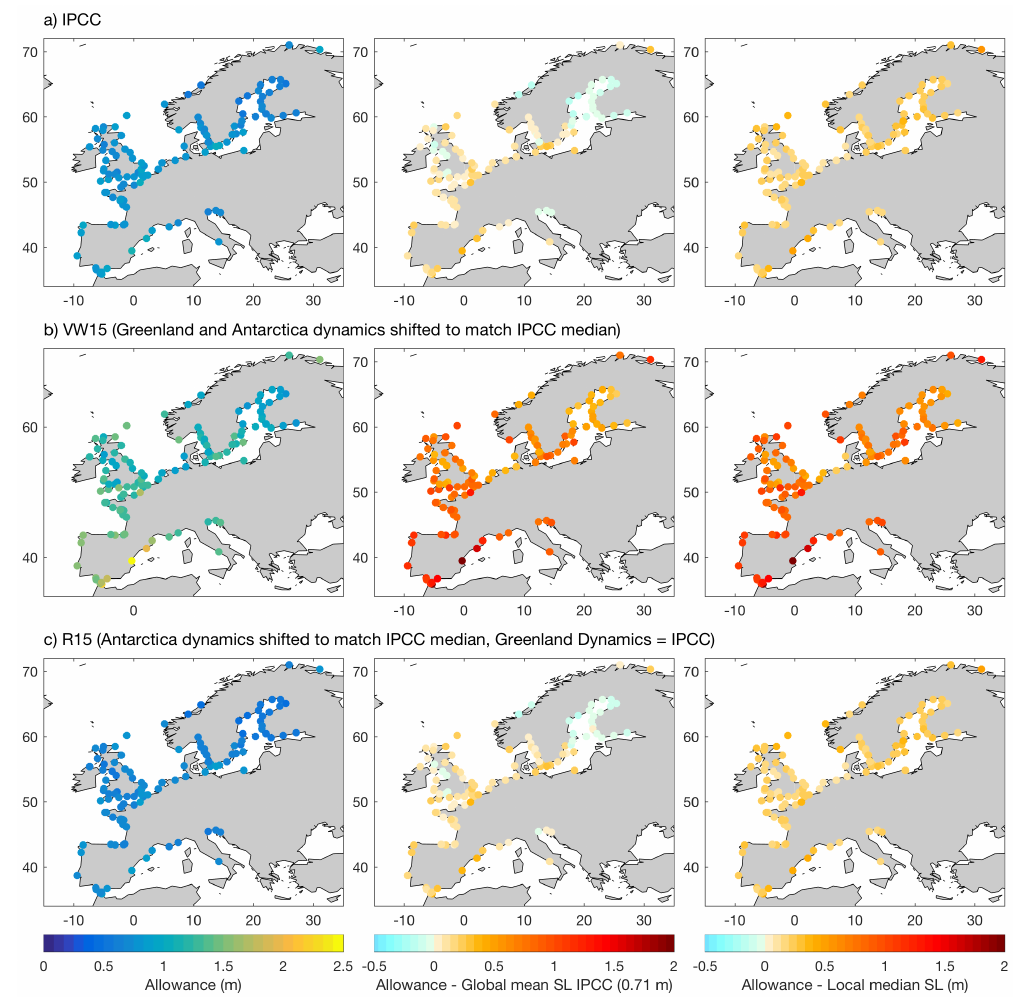
Figure 7. Same as Figure 6, but zoom on European region. Scenarios ( a ) IPCC; ( b ) VW15; ( c )